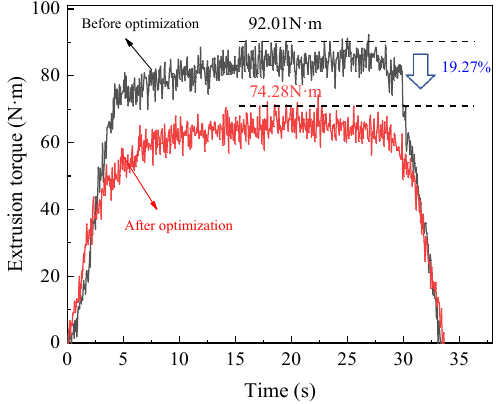
Figure 25. Optimization results of extrusion torque.